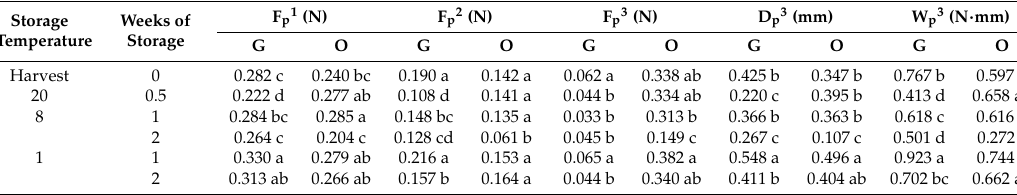
Table 6. Influence of storage temperature and duration on F p1 , F p2 , F p3 , D p3 and W p3 . Means with the same letters in a column are not significantly different at p ≤ 0.05 in Fisher’s multiple range test. G: ‘Goldrich’ and O: ‘Orangered ®